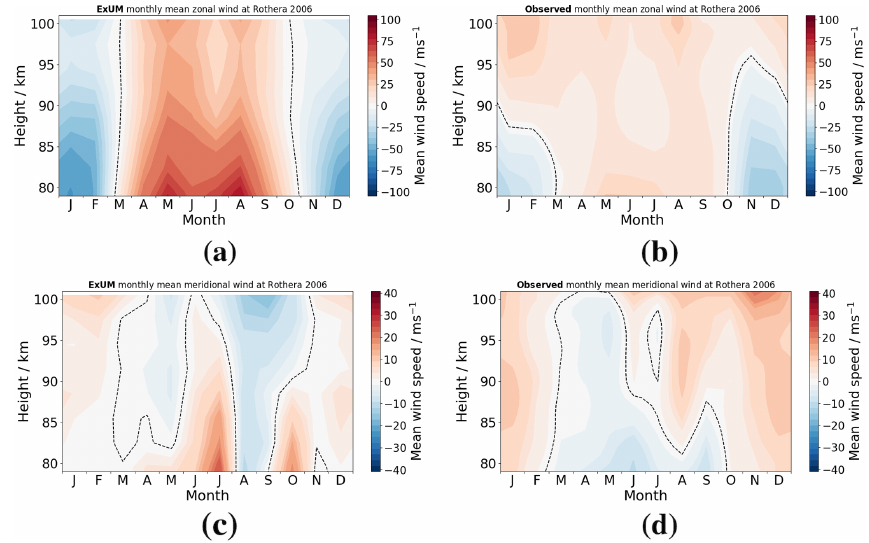
Figure 17. Time–height monthly-mean wind contours at Rothera in 2006 comparing (a) ExUM zonal wind without the USSP with (b) ob- served zonal wind and (c) ExUM meridional wind without the USSP with (d) observed meridional wind. The dashed black line represents the zero-wind line. Colour bars are kept consistent left to right for